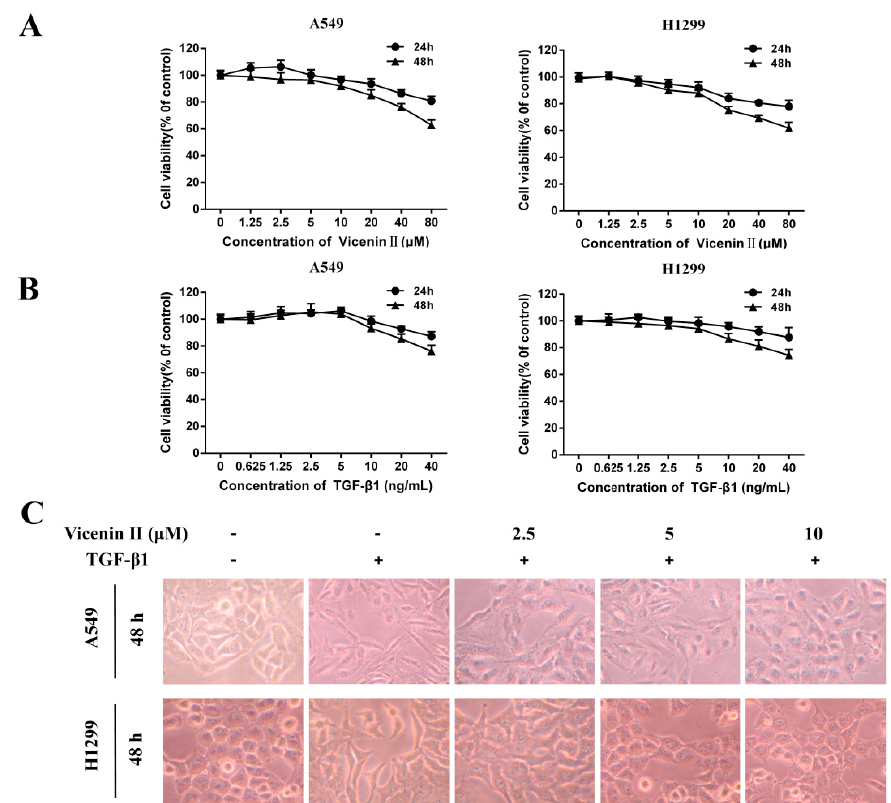
Figure 2. Effects of ViceninII and transforming growth factor (TGF)- β 1 on the viability and morphology changes of lung adenocarcinoma A549 and H1299 cells. The cell viability of A549 and H1299 cells treated with ( A ) ViceninII (1.25, 2.5, 5, 10, 20, 40 and 80 µ M), ( B ) TGF- β 1 (0.625, 1.25, 2.5, 5, 10, 20 and 40 ng/mL) for 24 h and 48 h was determined by MTT [3-(4,5-dimethythiazol-2-yl)-2,5-diphenyl tetrazoliumbromide] assay. Cells were treated with TGF- β 1 (5 ng/mL) for 48 h and co-treated with ViceninII for the last 24 h, and the cell morphology was observed ( C ). Magnification × 200.